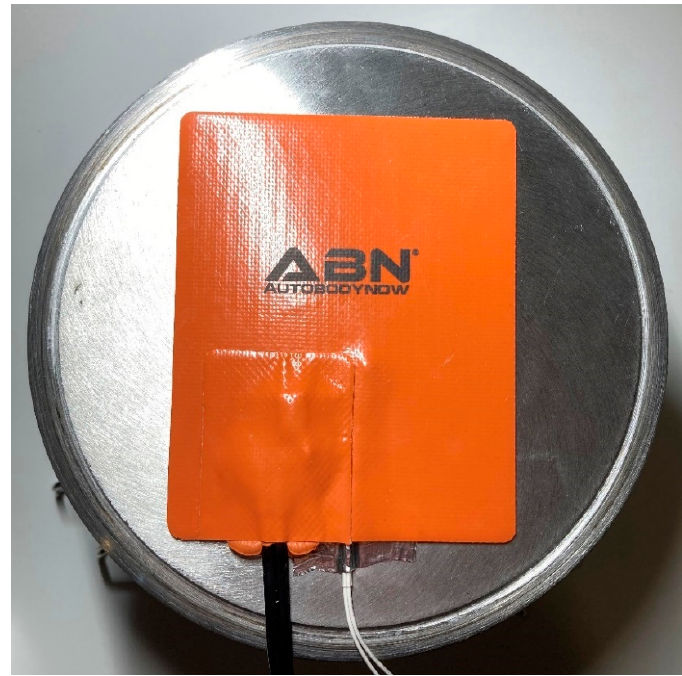
Figure 11. The heating element was adhered to the base of the chamber, with the thermistor se- cured on the interface.